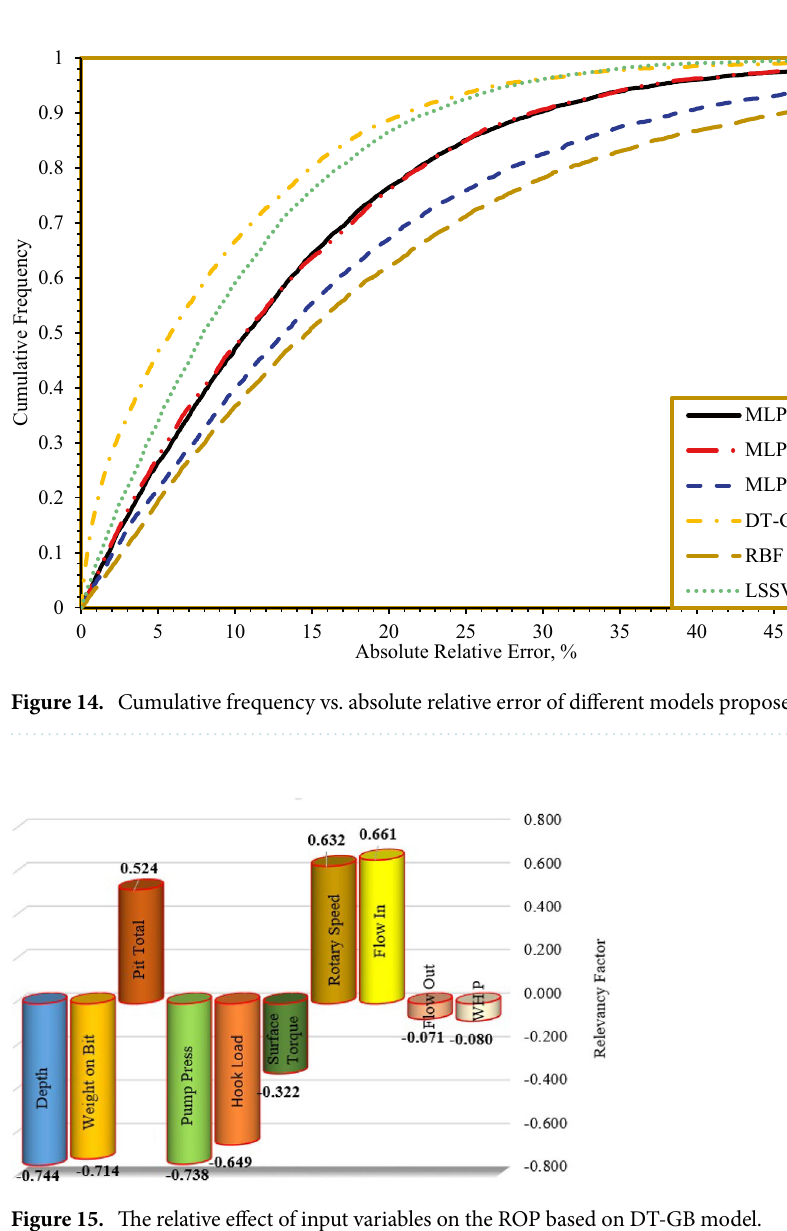
Figure 15. The relative effect of input variables on the ROP based on DT-GB